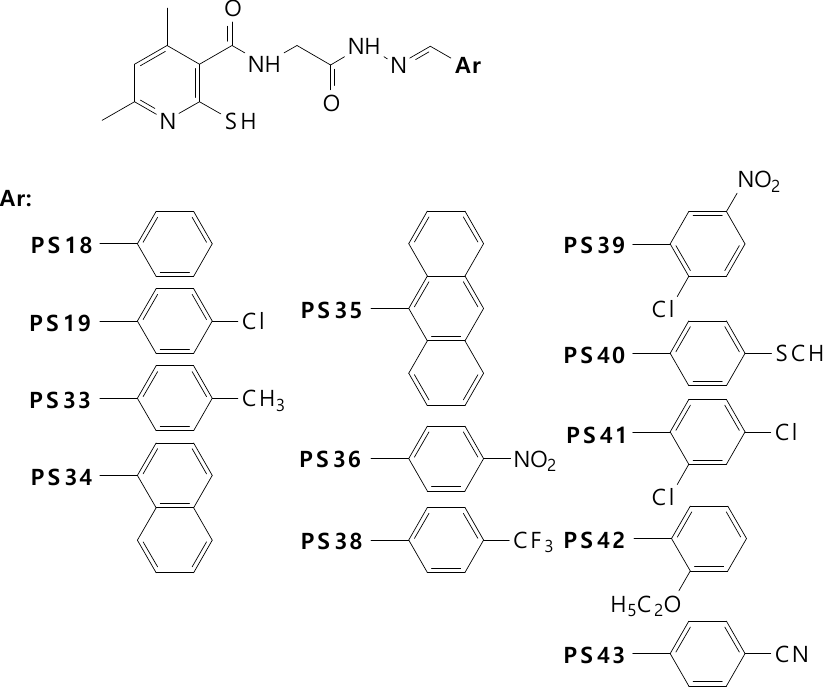
Figure 1. New derivatives of dimethylpyridine.